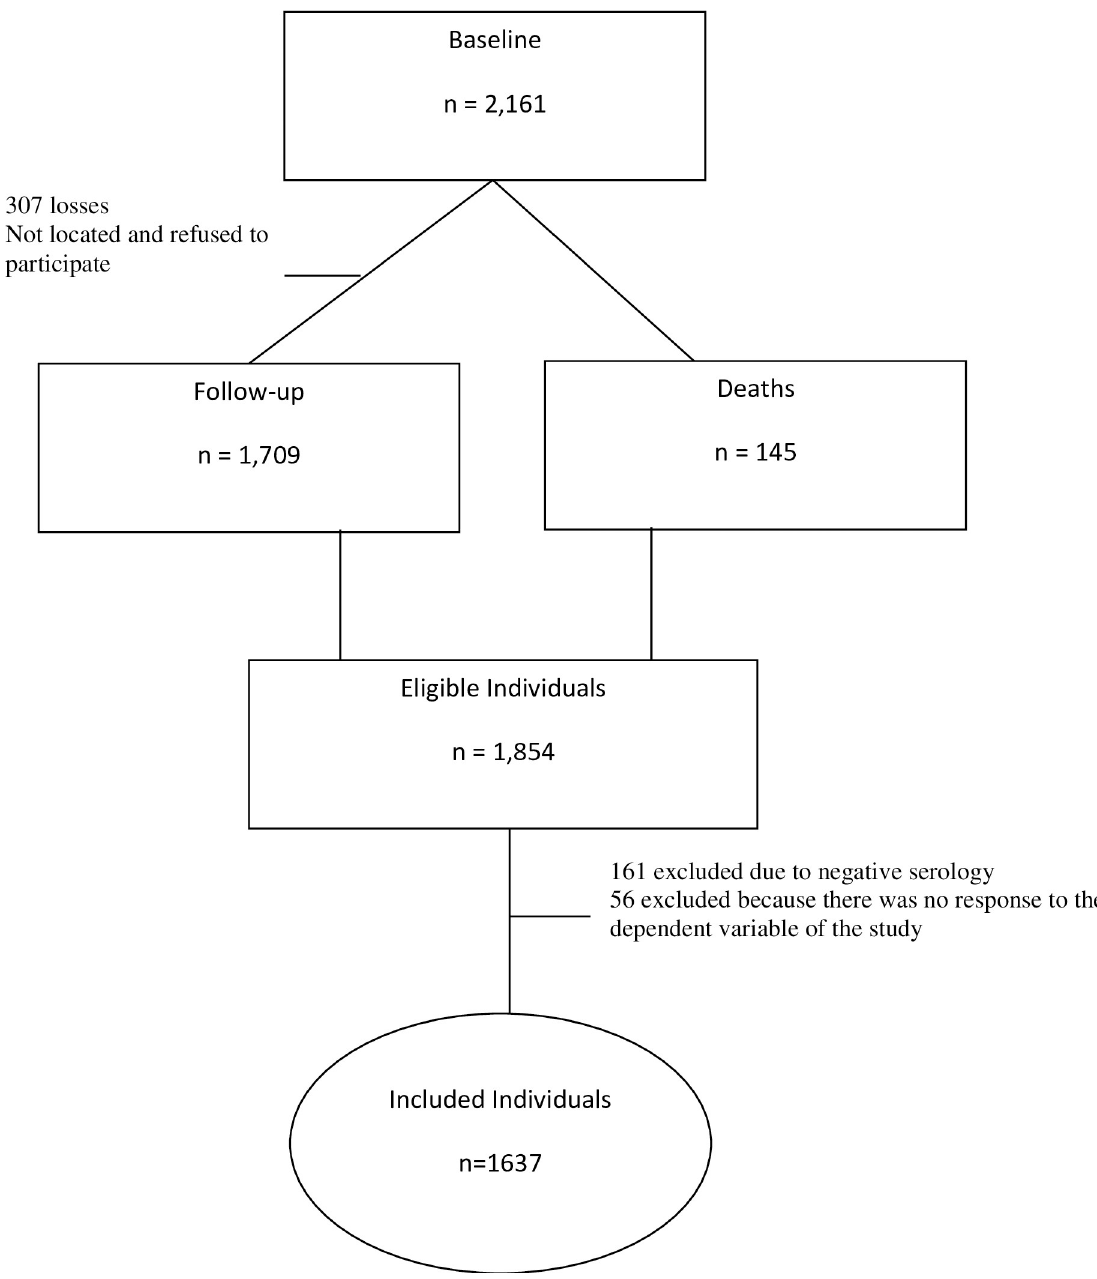
Fig 1. Flowchart showing the number of eligible, lost, and excluded CD patients in the study.